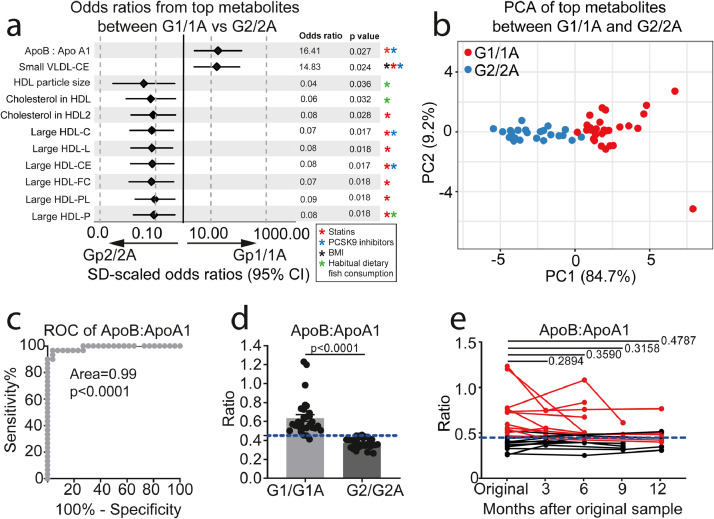
ApoB:ApoA1 as a clinical biomarker for stratified JSLE groups. (a) Forest plot from logistic regression analysis displaying the OR and 95% CI of 11 metabolites that passed p value correction for multiple testing between Group-1/1A (n=30) and Group-2/2A (n=26). Data was normalised for clinical parameters, demographic information, BMI, disease parameters (CRP, dsDNA, C3, lymphocyte count, disease duration, SLEDAI-2000) and treatment (Prednisolone, Hydroxychloroquine, Mycophenolate, Methotrexate, Azathioprine and Vitamin D). Corrected p-values (Holm-Sidak) displayed for each metabolite. Stars represent metabolites that are statistically significantly affected by BMI (Black), statins (Red)(38-40), PCSK9 inhibitors (Blue)(40) and habitual dietary fish consumption (Green)(41). (b) Principle component analysis using the 11 statistically significant metabolites between Group-1/1A (n=30, red) and Group-2/2A (n=26, blue) identified in (A). (c) ROC curve analysis of the ApoB:ApoA1 ratio of patients in Group-1/1A (n=30) compared to patients in Group-2/2A (n=26). Area under the curve (AUC) displayed. (d) ApoB:ApoA1 ratio (higher ratios=higher risk) measured in Group-1/1A (n=30) and Group-2/2A (n=26). Cut-off identified from the ROC analysis displayed as the blue dashed line. Mean, unpaired two-tailed t-tests. (e) Longitudinal analysis of ApoB:ApoA1 ratio at 3 month intervals over 12 months (baseline (n=22), 3 months (n=9), 6 months (n=12), 9 months (n=6) and 12 months (n=9)). The cut off identified from the ROC curve analysis is displayed as the blue dashed line. Red points/lines represent patients that started with a baseline ApoB:ApoA1 ratio above the cut off. Paired t-tests.